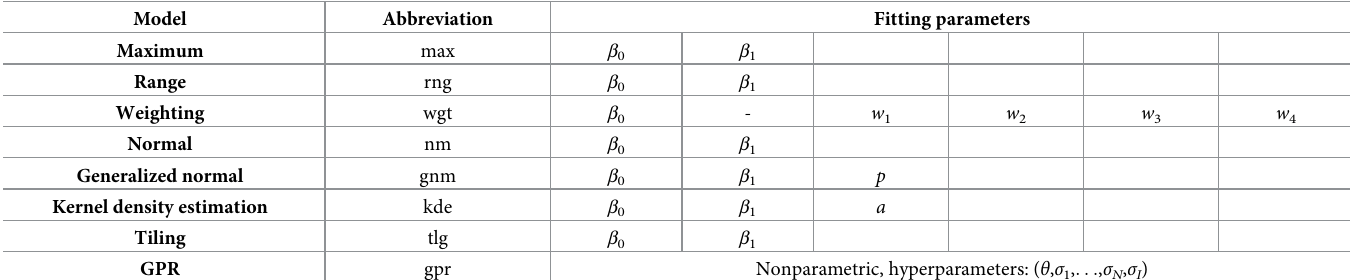
Table 1. Overview of model